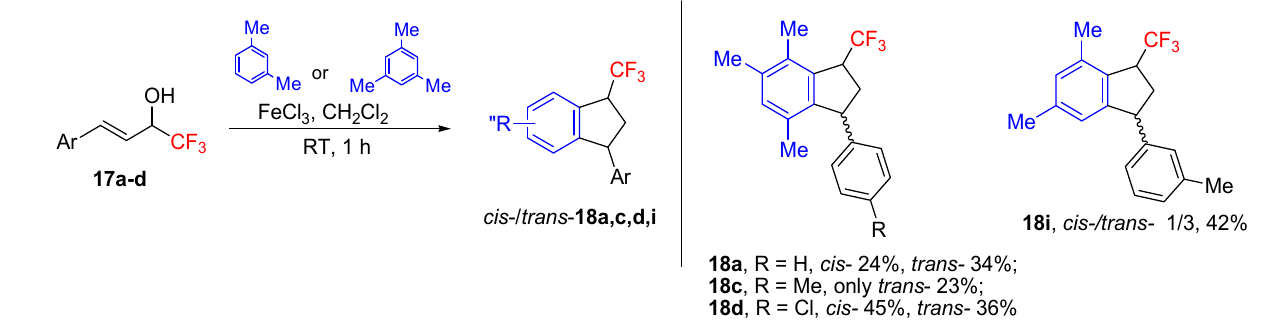
Scheme 13. Synthesis of 1-CF 3 -indanes 18a,c,d,i from CF 3 -allyl alcohols 17a-d and arenes.